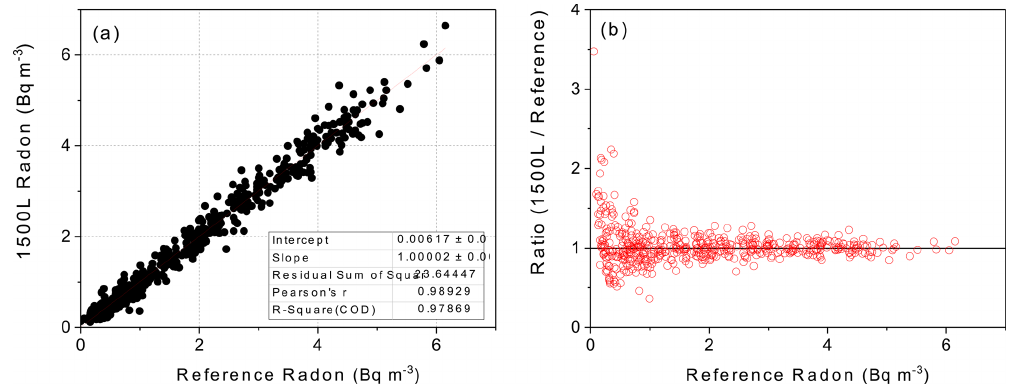
Figure 16. (a) regression of corrected 1500L radon monitor observations with reference monitor observations, and (b) ratio of corrected to reference observations as a function of ambient radon concentration.